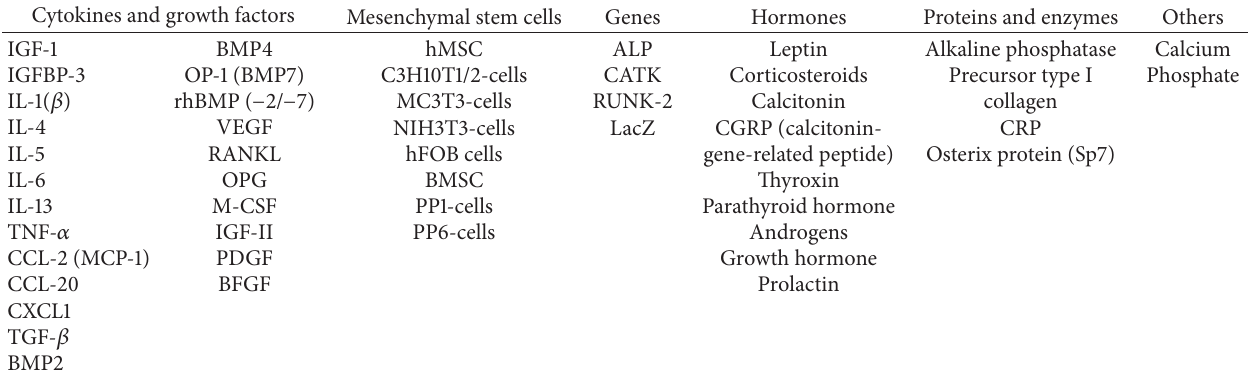
Table 1: Investigated